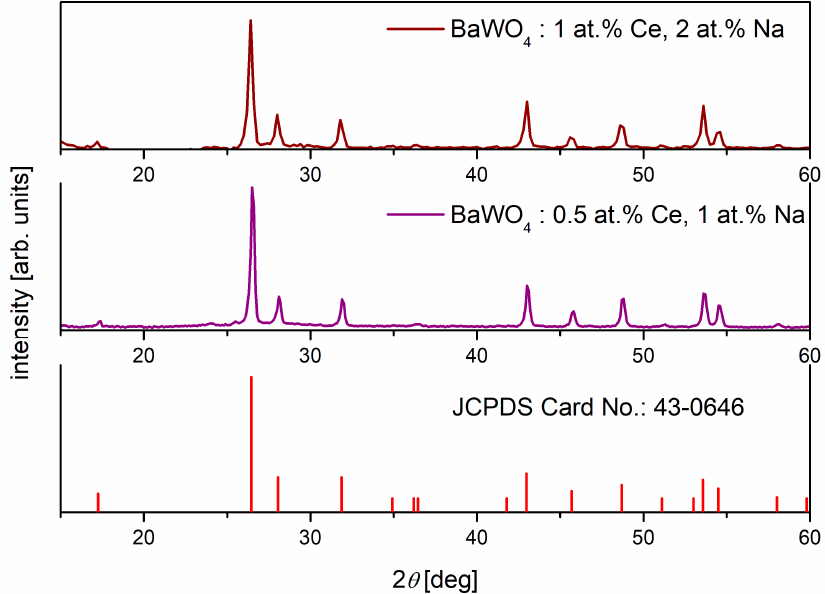
Figure 3. Diffractograms of the analyzed BaWO 4 single crystals doped with cerium and co-doped with sodium ions. The red diffractogram indicates the position and relative intensity of JCPDS card no.: 43-0646.